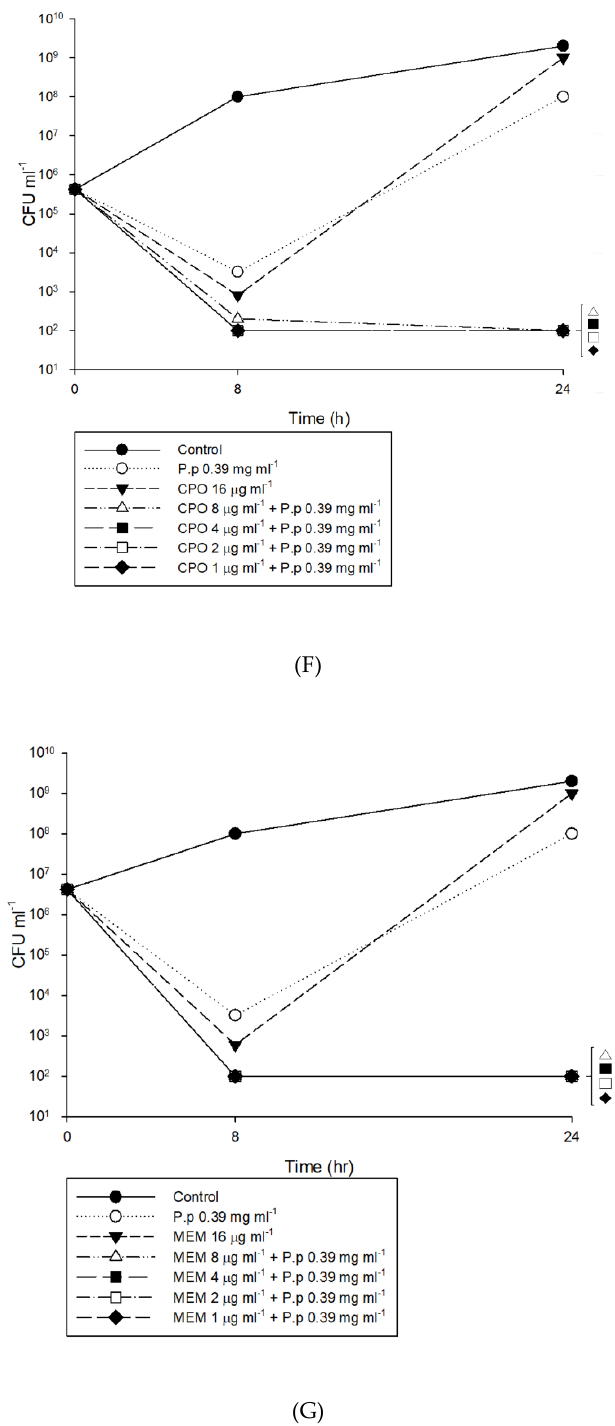
Figure 3. Time-kill results for the crude extract of Pongamia pinnata seed coat (concentration: 0.5 × minimum inhibitory concentration, MIC) in combination with seven antibiotics including ( A ): ampicillin (AMP), ( B ): cefazolin (CZ), ( C ): cefuroxime (CXM), ( D ): cefotaxime (CTX), ( E ): aztreonam (ATM), ( F ): cefpirome (CPO), and ( G ): meropenem (MEM) against methicillin-resistant Staphylococcus aureus 3322 incubated for 48 hr. The concentration used was 1 × MIC, and 8, 4, 2, and 1 µ g mL − 1 of each of the di ff erent antibiotics were evaluated. The inoculum concentration was 5 × 10 5 colony forming units (CFU) mL − 1 .